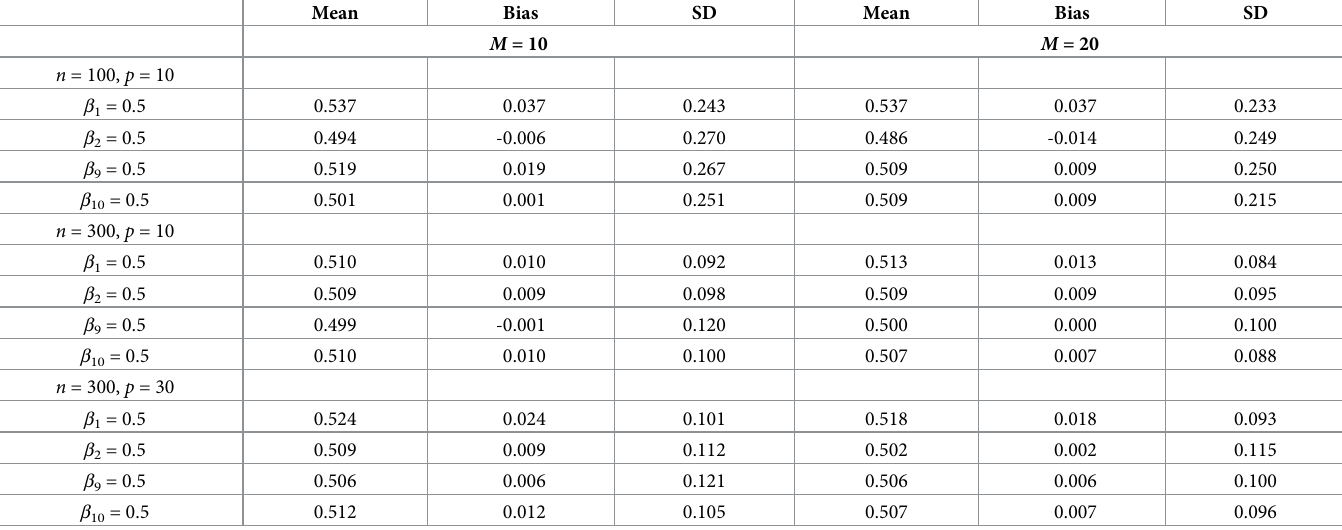
Table 1. Simulation result of appIC sparse estimation with b 0 = 0.5 and baseline cumulative hazards function Λ 0 ( t ) = t . Mean